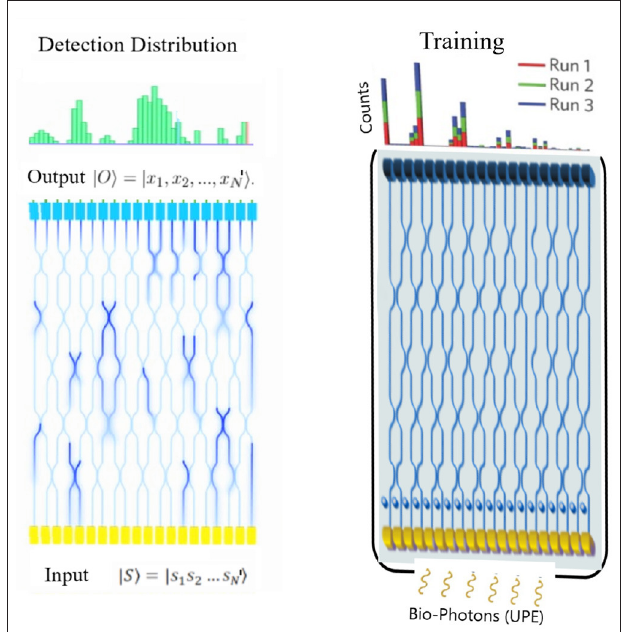
FIGURE 4 | On-chip optical interferometer with N’ inputs and N’ outputs. The output patterns can be processed for feature extraction via machine learning techniques. It is expected that for each cognitive task or decision making, a similar pattern (in average) forms after many runs under training for specific tasks. The features of the average pattern can be recognized by deep learning methods, or specifically by convolutional neural networks (CNNs) on a